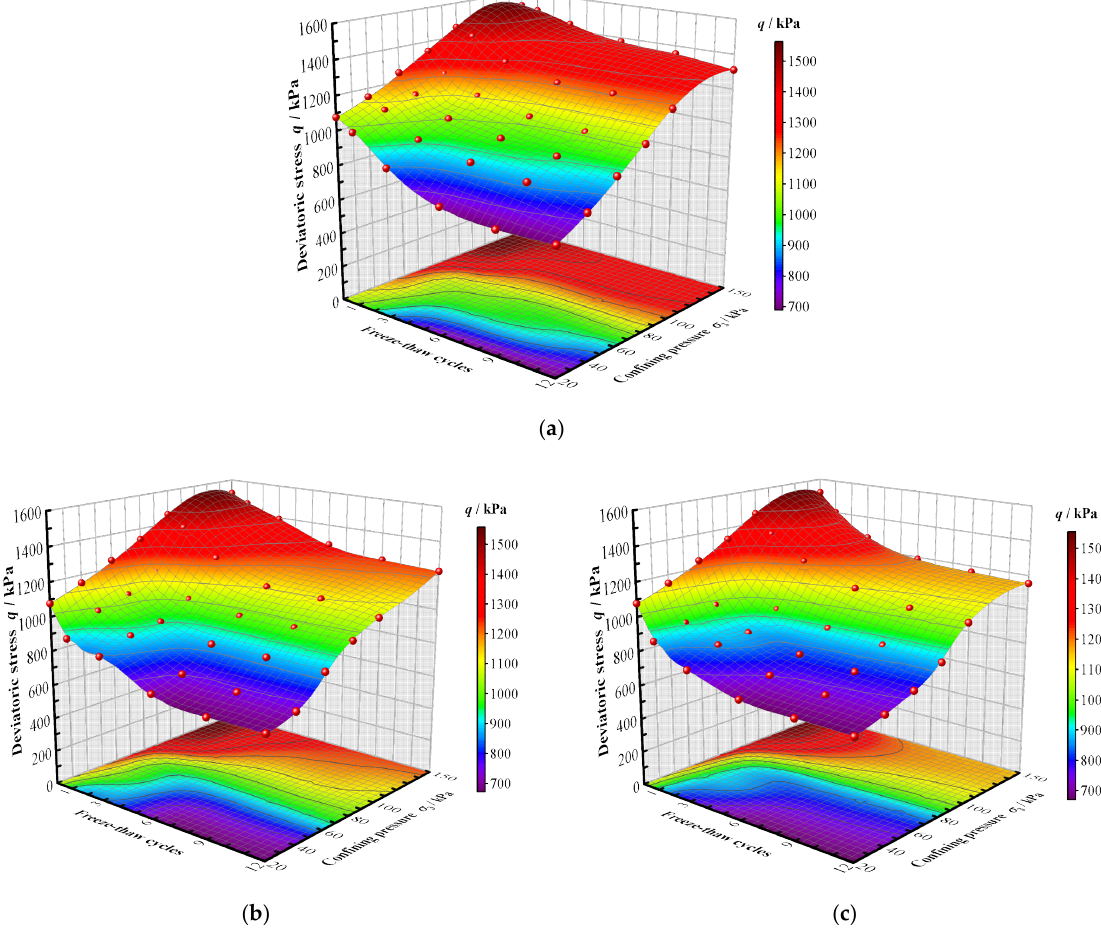
Figure 5. The relationship between strength and confining pressure under different F-T cycles, ( a ) The freezing condition of −5 °C, ( b ) The freezing condition of −10 °C, ( c ) The freezing condition of −15 °C.